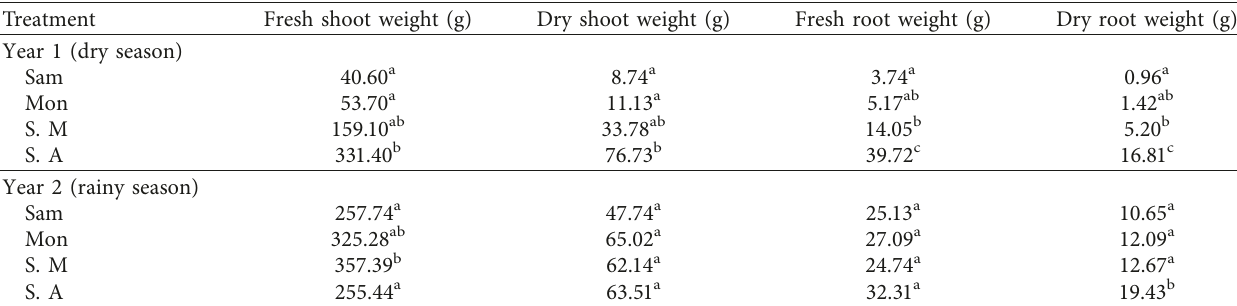
Table 5: Mean fresh and dry weights of shoot and roots of rootstocks after 12 weeks of root-knot nematode infestation.